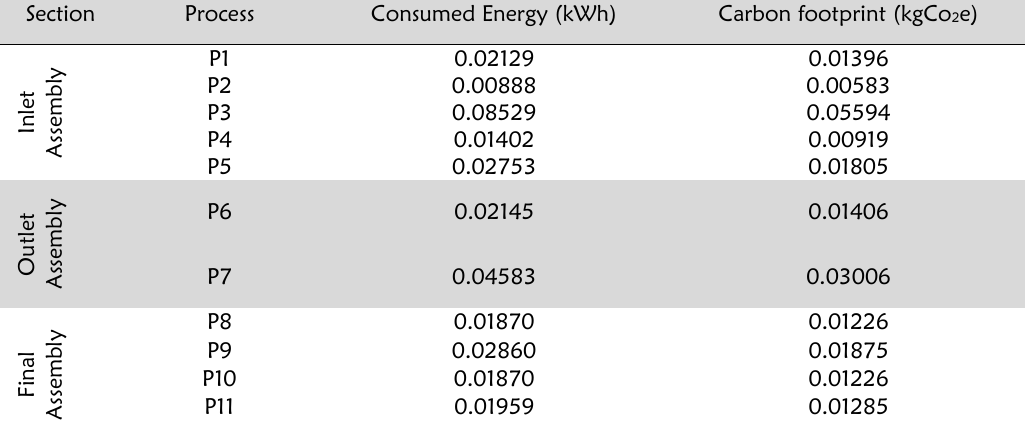
Table 3: Computed carbon footprints of the welding operations.